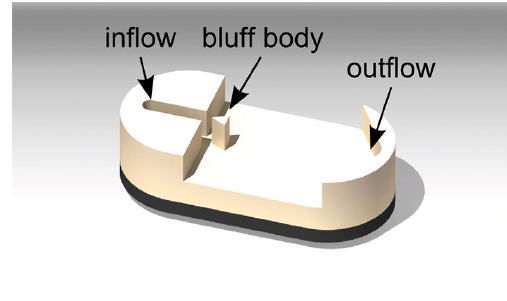
Figure 6. Insert manufactured using 3-D printing with integrated triangular bluff body and sealing on the bottom side (Schmitt et al., 2013b).